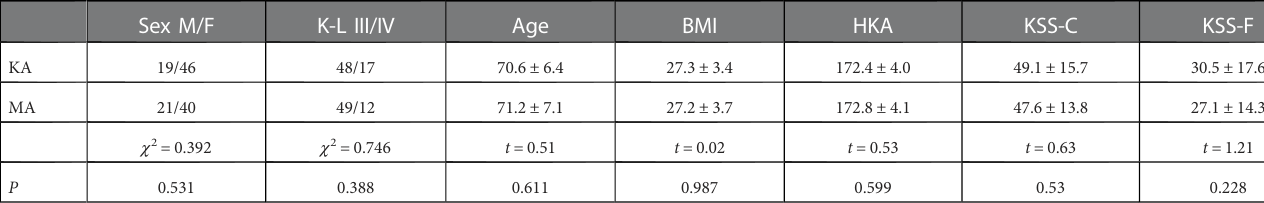
TABLE 1 Comparison of preoperative data of patients in the KA-TKA and MA-TKA groups (mean ± SD).